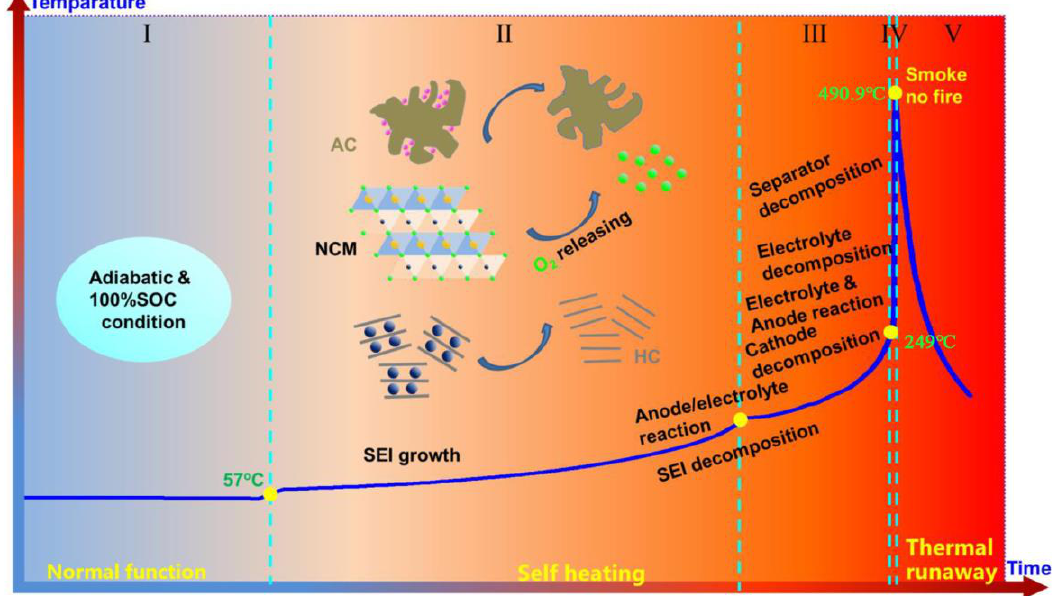
Figure 16. Schematic diagram of thermal runaway of NCM-based LIBC [99].